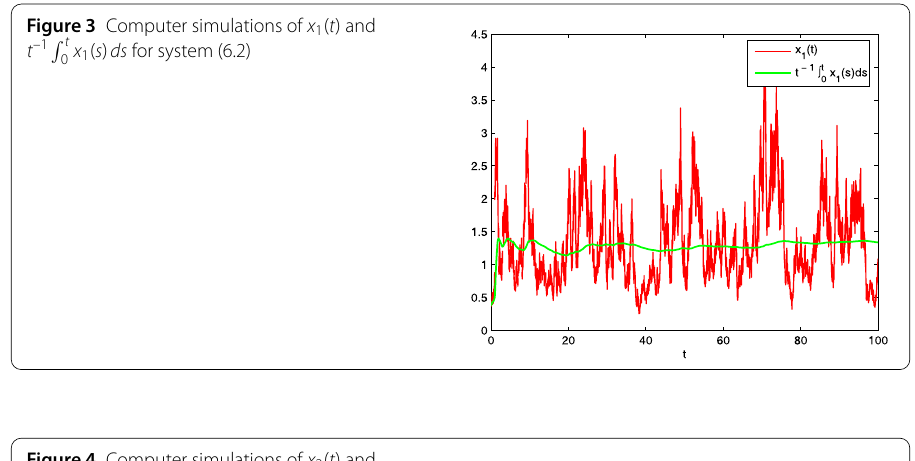
Figure 4 Computer simulations of x 2 ( t ) and x 2 ( s ) ds for system t –1 t 0